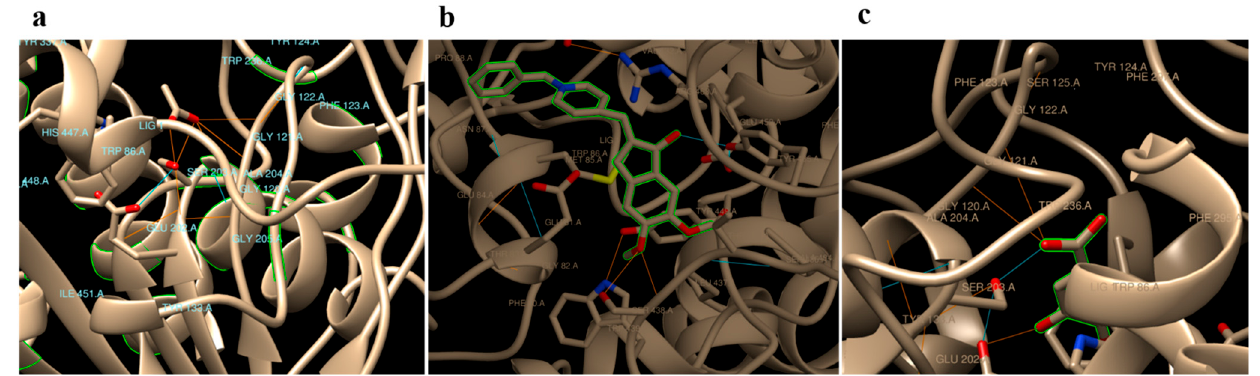
Figure 1. Predicted binding modes of acetylcholine ( a ), Aricept ( b ), and gallic ( c ) with hAChE (PDB Code: 4EY7).